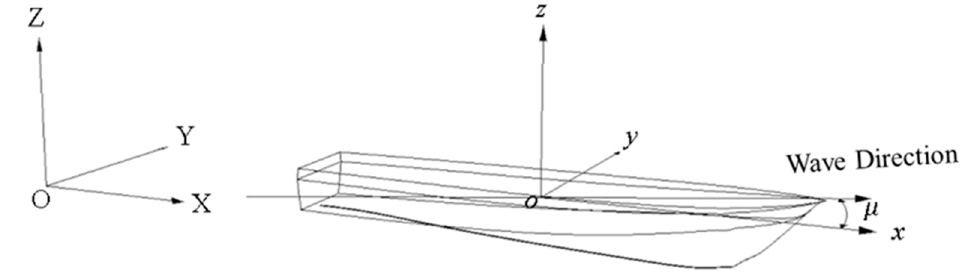
Figure 1. Schematic of the hull coordinate systems.